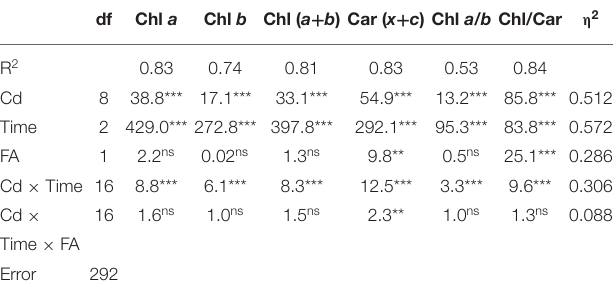
TABLE 1 | Two-way analysis of covariance (ANCOVA) of pigment concentrations and their ratios measured in Spirodela polyrhiza fronds of different age (FA: MF, DF 1 , DF 2 , and GDF) exposed for 6, 24 and 72h (time) to different concentrations of cadmium (Cd: 0–890 µ M).